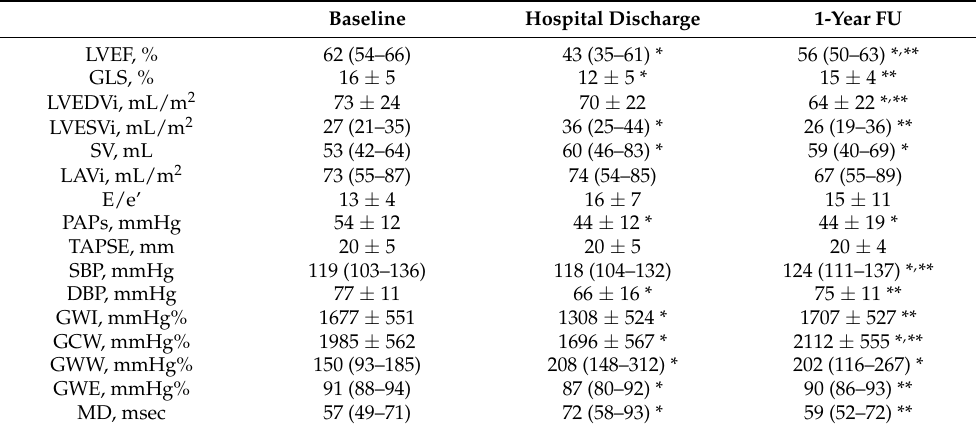
Table 3. Echocardiographic parameters at baseline, at hospital discharge after TEER, and 1-year